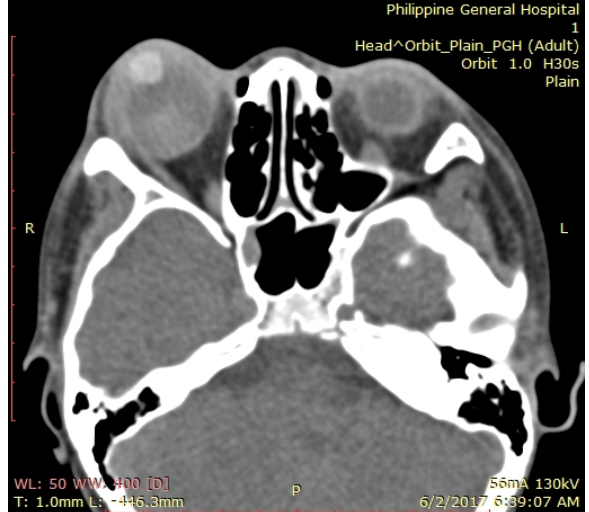
Figure 5: Third-week postoperative orbital computerized tomography scan